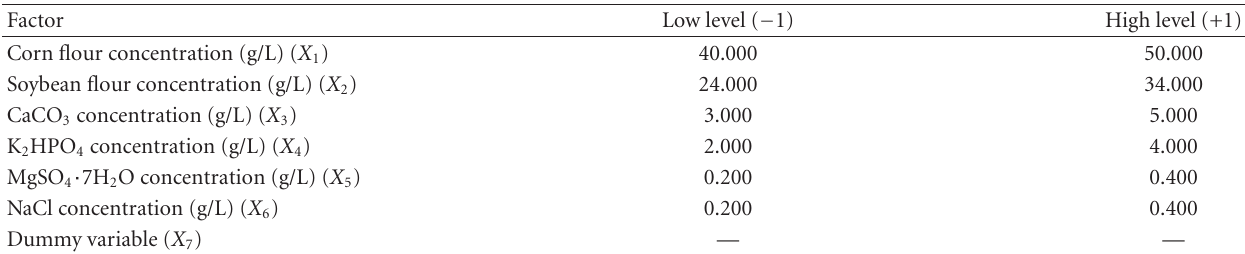
Table 1: Two levels of the factors used in Plackett-Burman